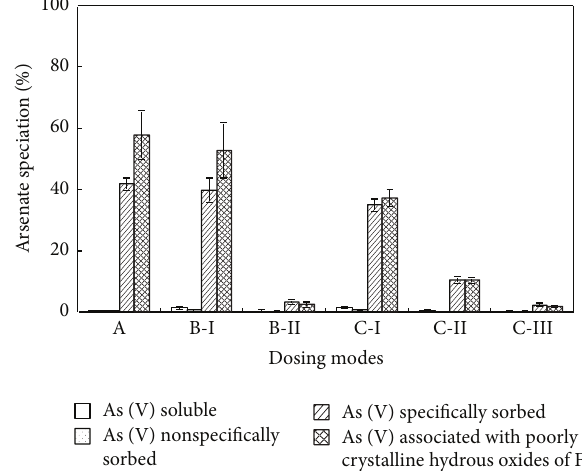
Figure 4: Percentage of As (V) extracted with a sequential extrac- tion procedure from the Fe-As (V) samples in different batches of = 7.0 dosing modes (pH Initial